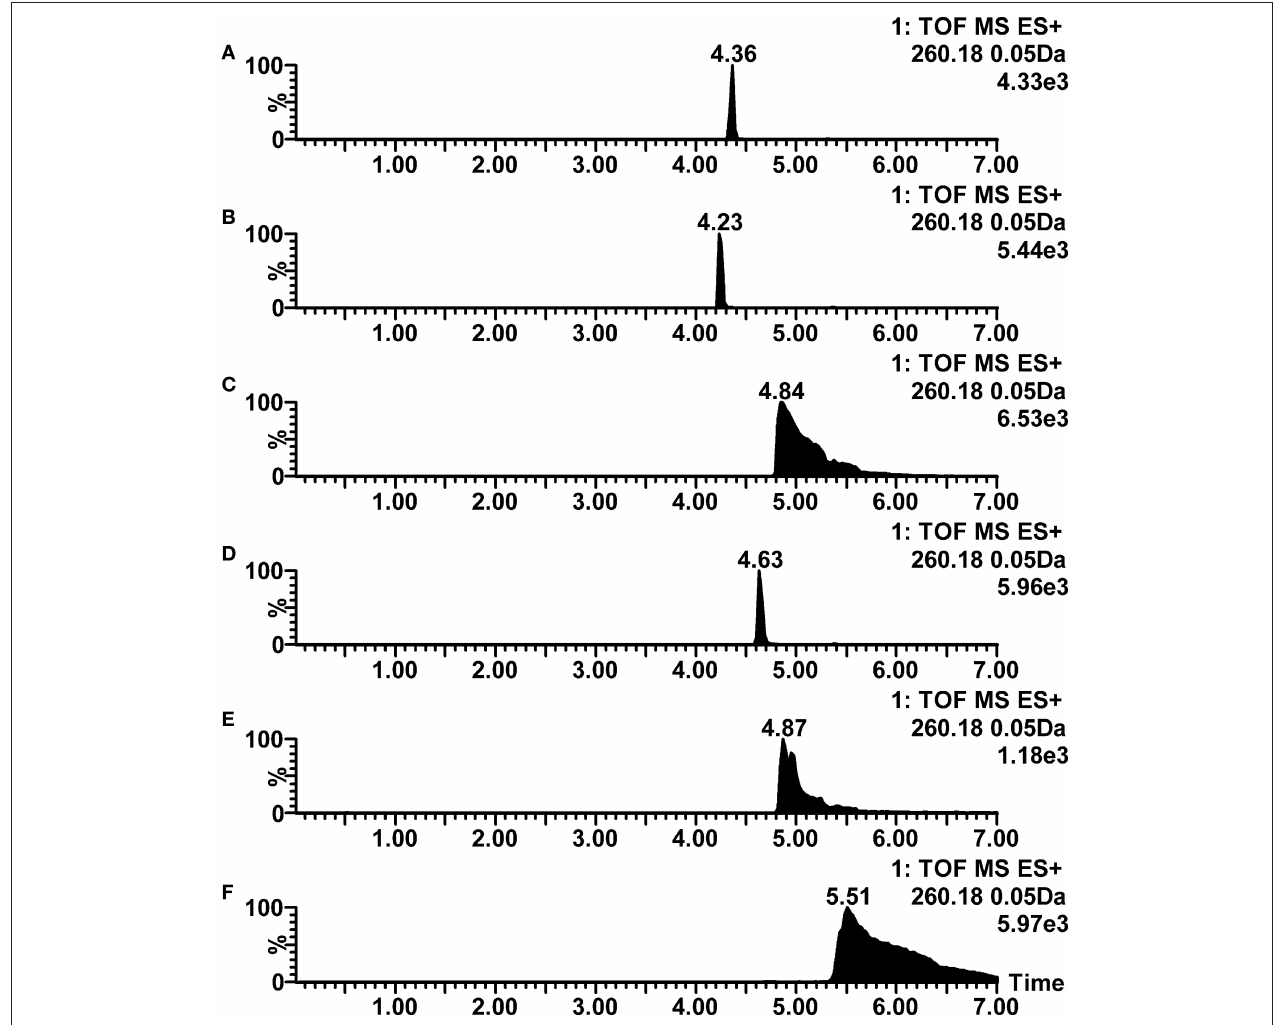
FIgurE 1 | Positive ion mode LC–ESI–TOF–MS ion chromatograms for propranolol at various mobile phase pH conditions. (A) 0.1% formic acid (pH 2.8); (B) 0.1% acetic acid (pH 3.2); (C) 2 mM ammonium formate (pH 6.0); (D) 0.05% acetic acid with 5 mM ammonium acetate (pH 4.4); (E) 2 mM ammonium acetate (pH 6.7); (F) 10 mM ammonia (pH